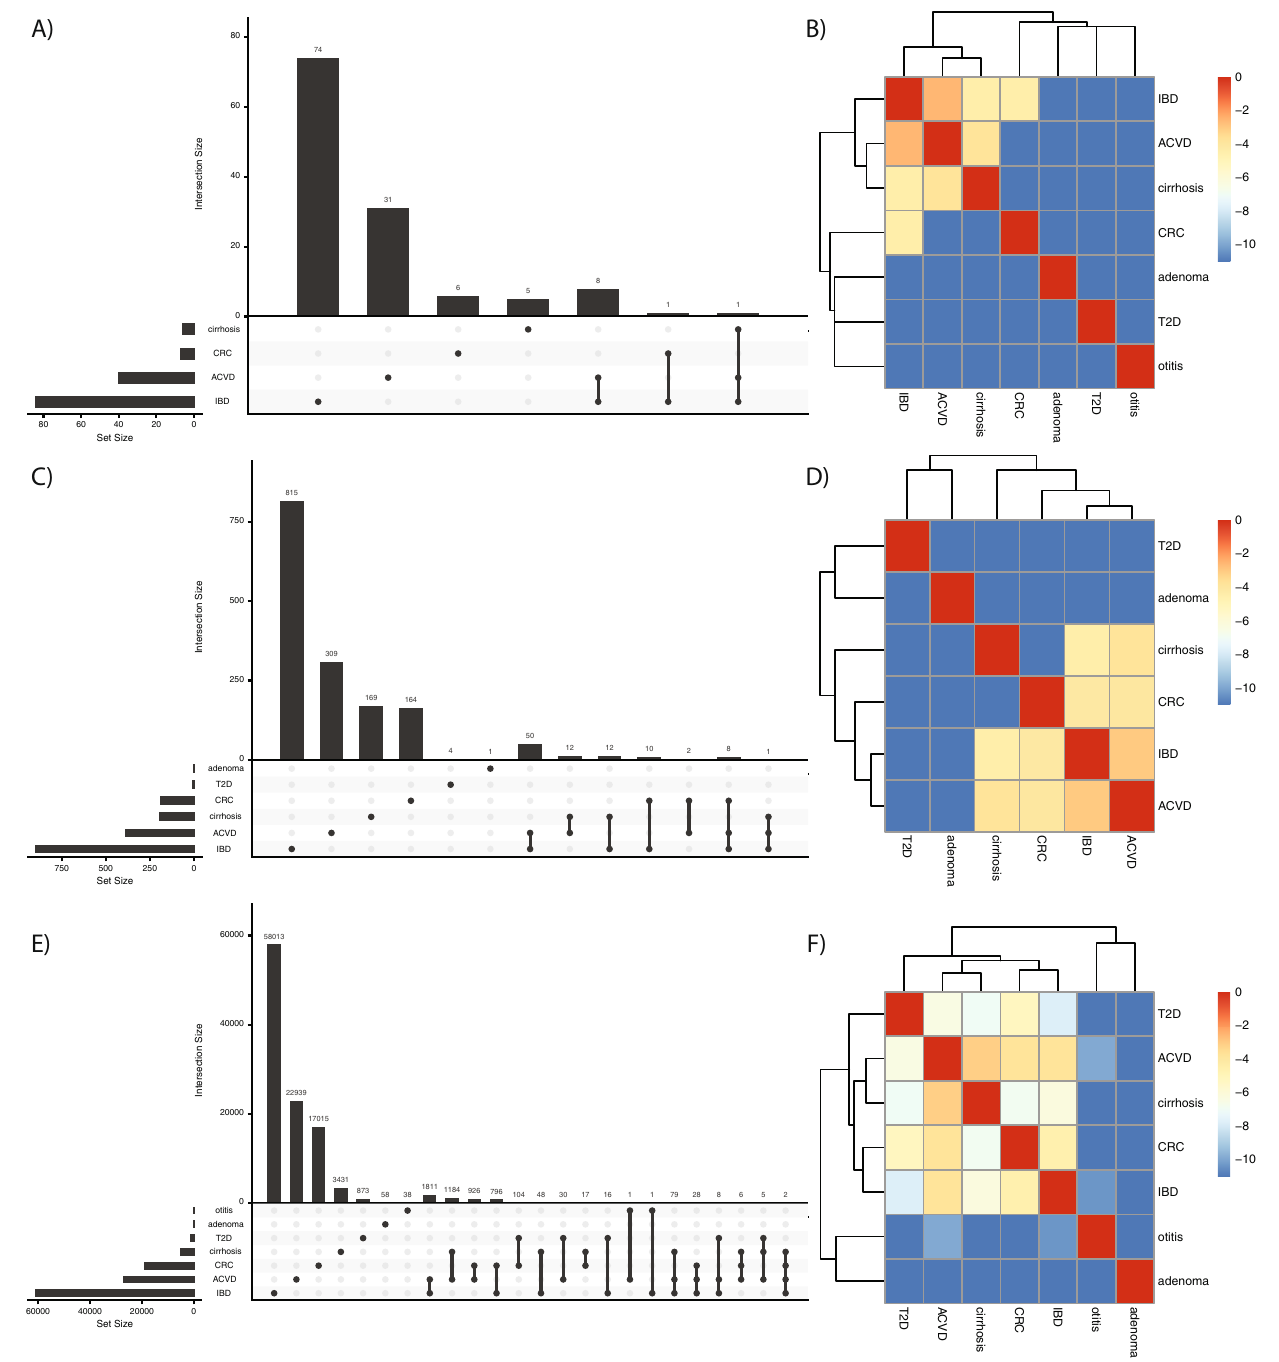
Fig. 4 The disease architecture of the human microbiome across seven phenotypes as a function of data modality. A , C , E describe the species, pathways, and gene families associated with each phenotype and the overlap therein, respectively. B , D , F show the natural log of pairwise jaccard similarity between binary vectors indicating all of the features (e.g., species or pathways or gene families) associated with a given